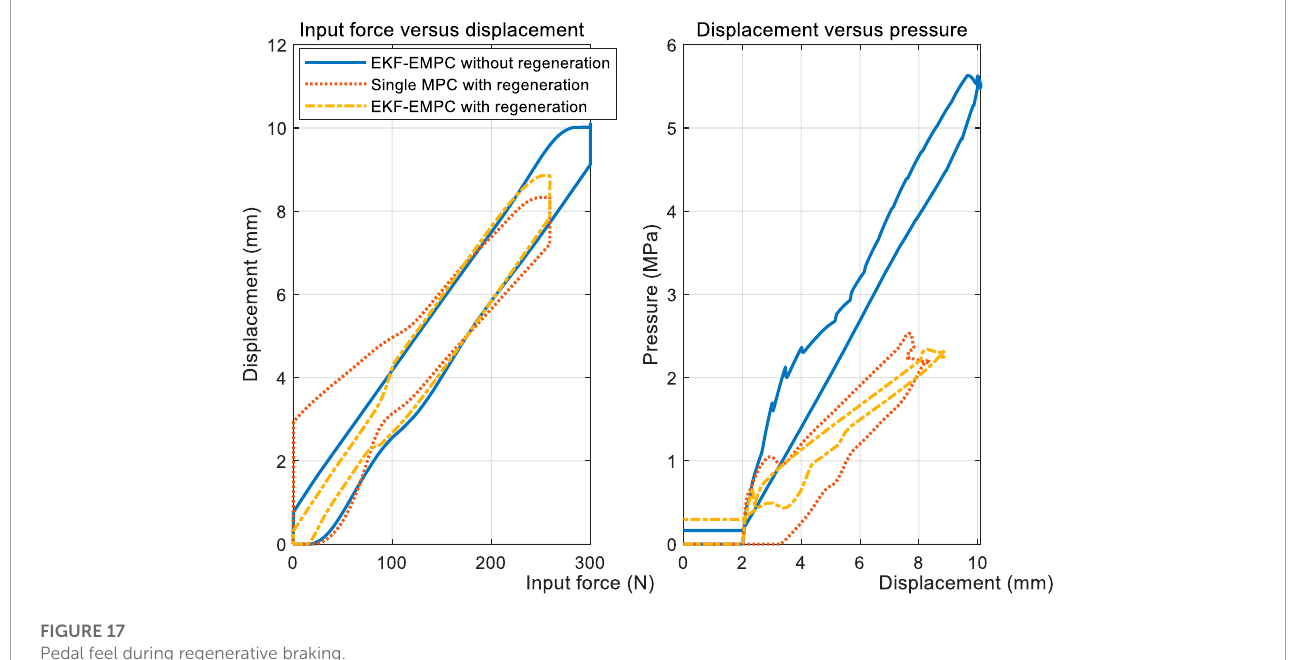
FIGURE 17 Pedal feel during regenerative